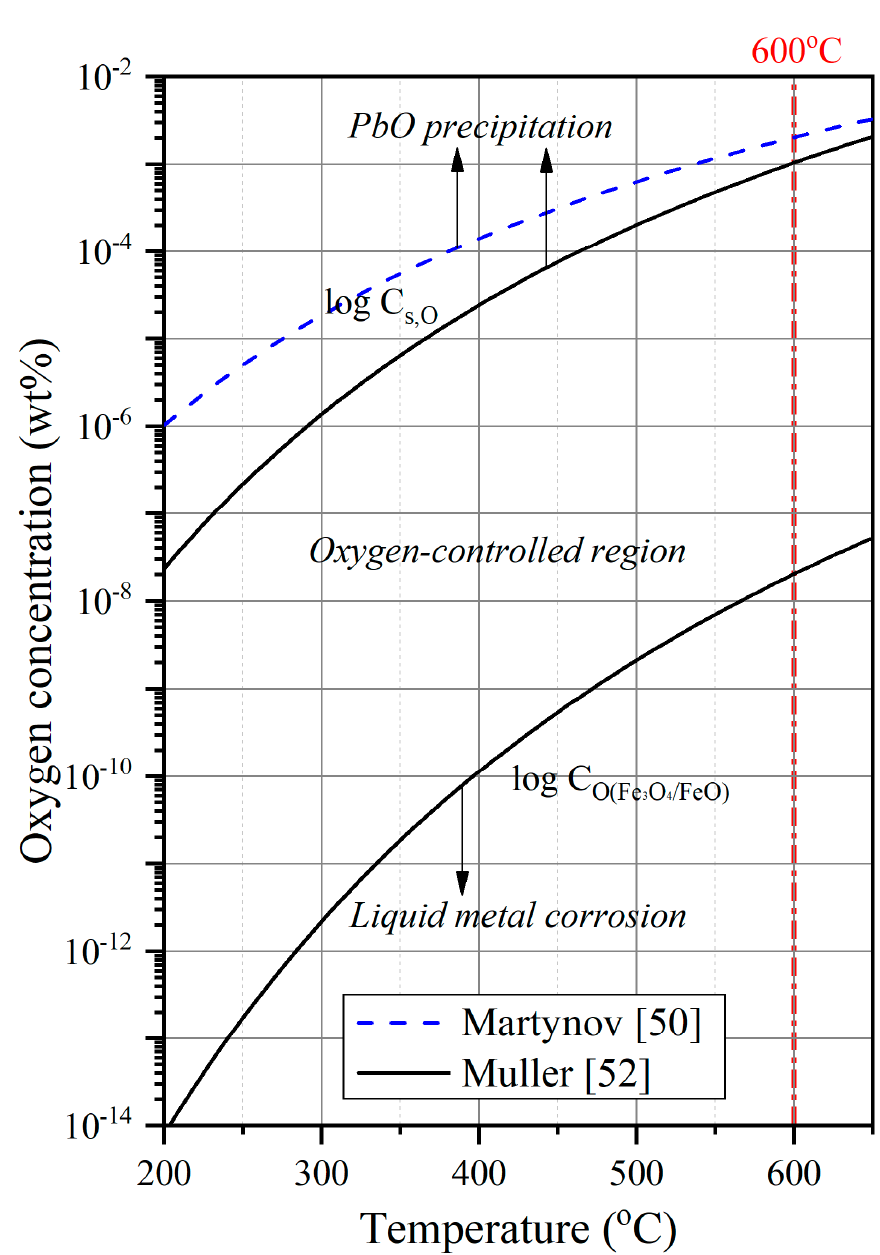
Figure 14. Stable oxygen control range in LBE as a function of LBE temperature [50,52].